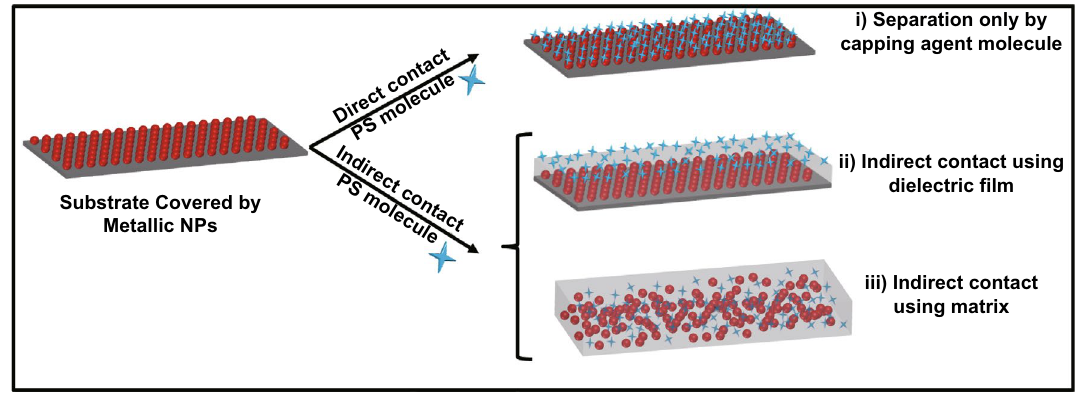
Fig. 10 Different approaches for fabrication of planar system with metal-enhanced singlet oxygen: (i) Direct contact between photosensitizer molecules and metal nanoparticles, (ii) Using dielectric (e.g., silica or polymer) film as spacer between the metal nanoparticles and photosen- sitizer molecules, and (iii) Using a dielectric matrix (e.g., polydimethylsiloxane) containing both metal nanoparticles and photosensitizer mol-